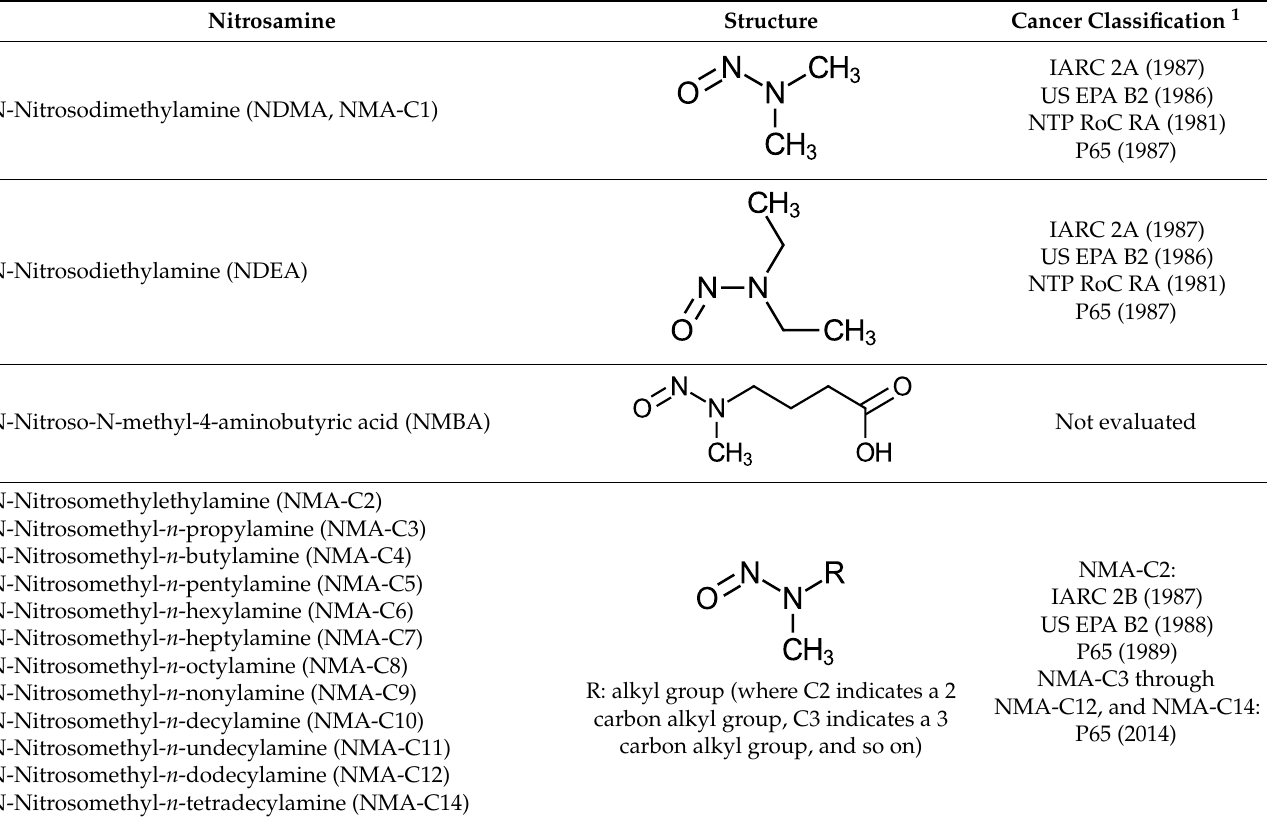
Table 1. Cancer classifications of some nitrosamines found in pharmaceutical drugs and structurally related N- nitrosomethylalkylamines (NMAs).